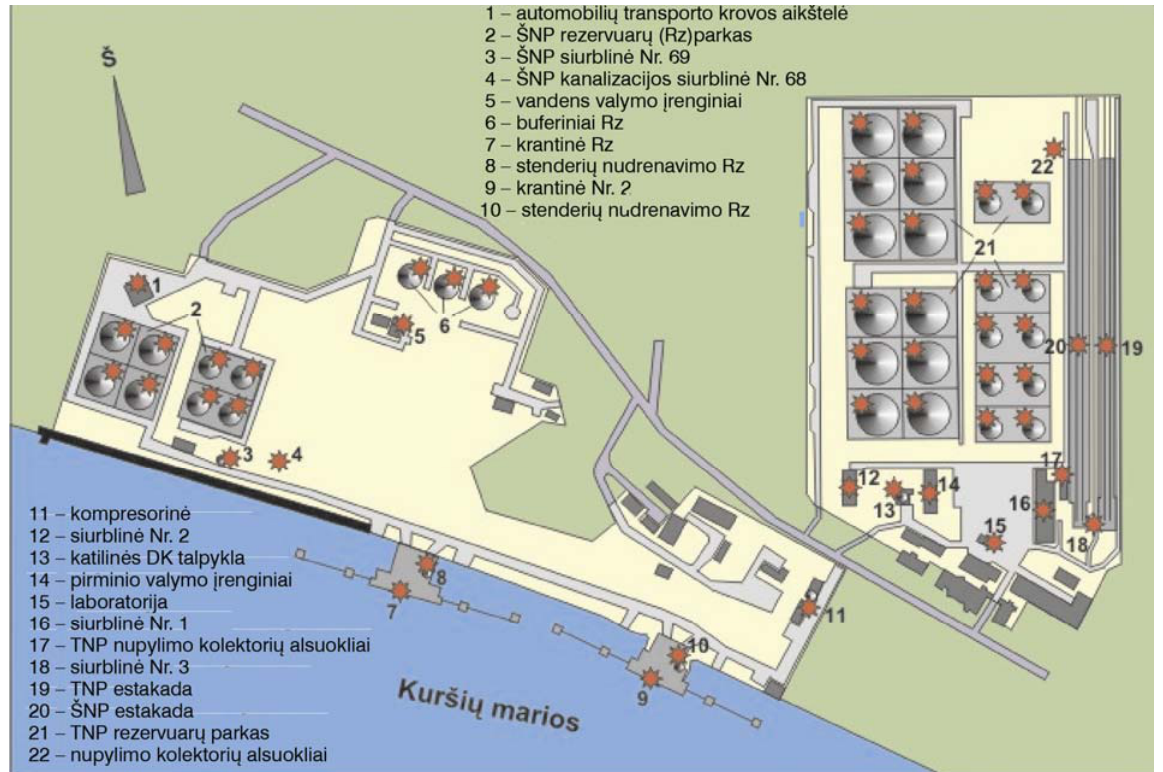
Fig 1. Scheme of VOC emission zones and technological systems of AB “Klaip ė dos